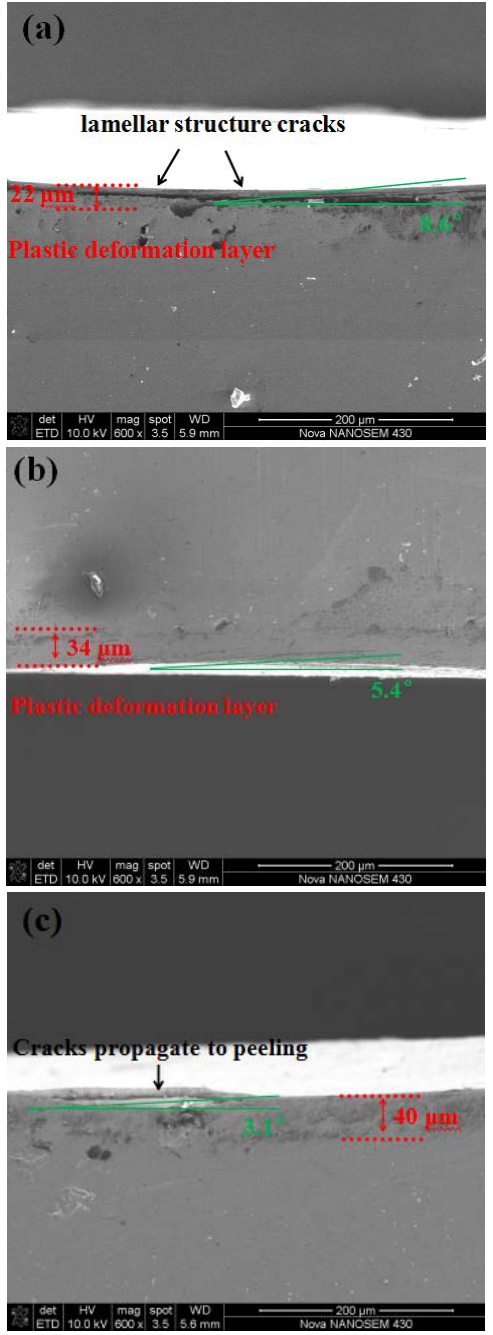
Figure 9. Micrographs of subsurface damage: ( a ) Quenched at 900 °C contact stress 3.2 GPa and 543,400 cycles to failure; ( b ) Quenched at 1000 °C contact stress 3.2 GPa and 572,000 cycles to failure; and, ( c ) Quenched at 1100 °C contact stress 3.2 GPa and 566,000 cycles to failure.